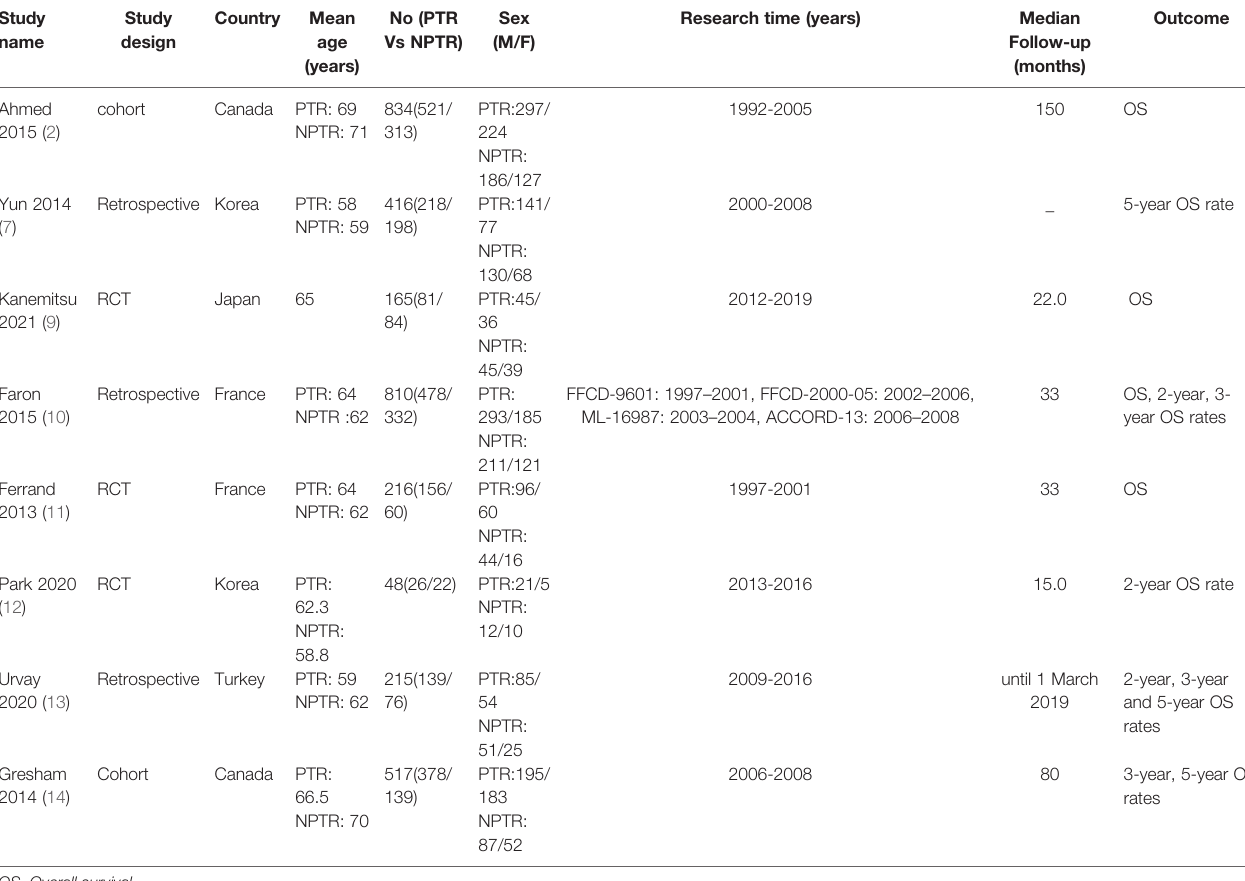
TABLE 1 | Characteristics of included studies and outcome